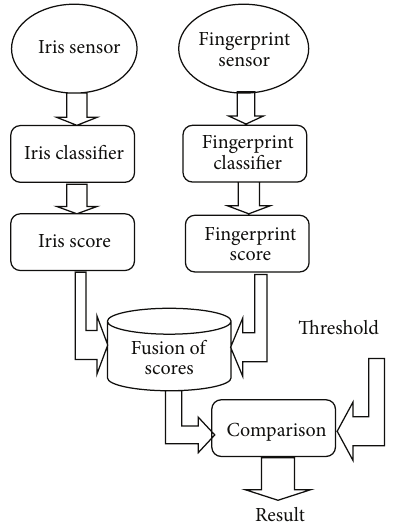
Figure 4: Score level fusion using iris and fingerprint biometric mo-